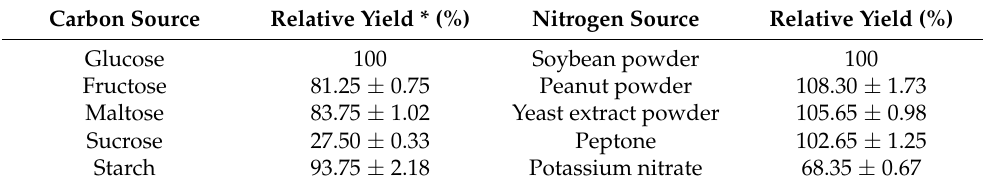
Table 4. Relative yield of aurones in different carbon and nitrogen sources in single-factor